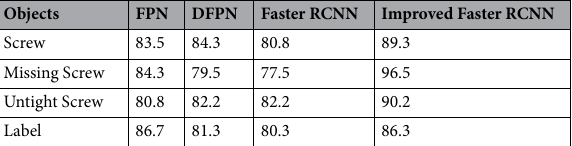
Table 4. Comparison of proposed model accuracy with other state-of-the-art methods.